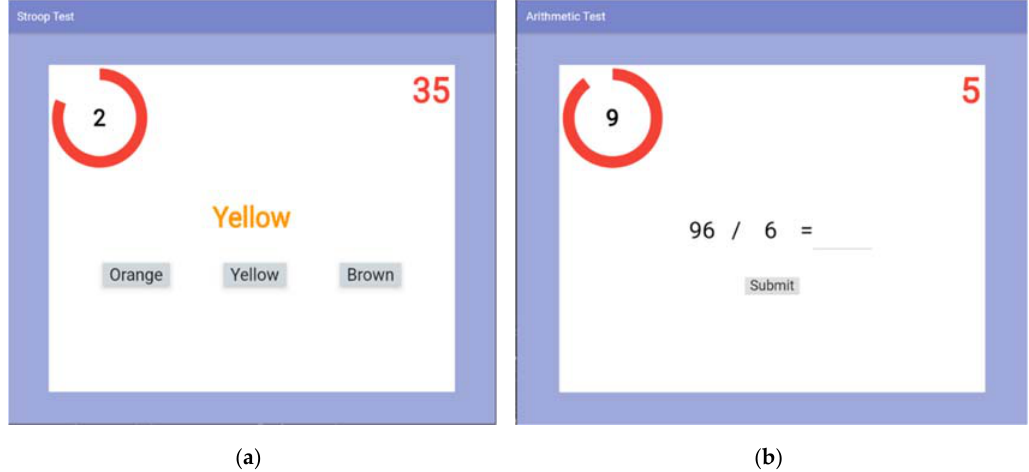
Figure 3. Examples of the interfaces of the experiment’s tasks. The subject’s score is displayed in the upper right corner of the screen. The countdown timer is displayed in the upper left corner of the screen. ( a ) The interface of Stroop Color Word Task. ( b ) The interface of Mental Arithmetic Task.